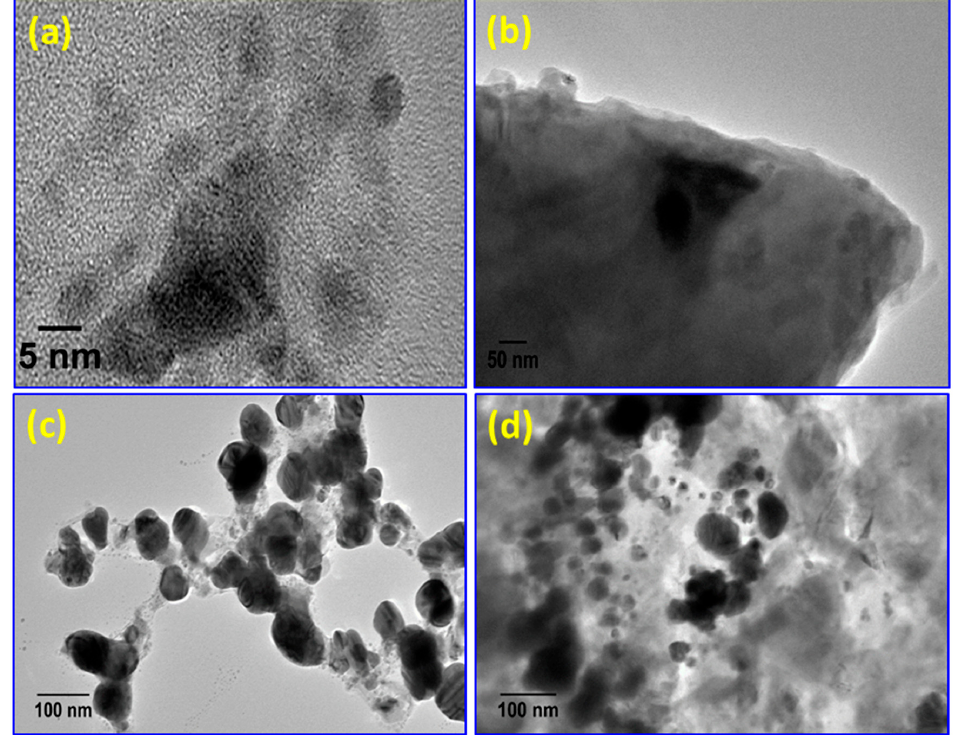
Figure 7. HRTEM micrographs of ( a ) AgNPs and ( b ) PS/AgNPs; ( c ) PMMA/AgNPs; and ( d ) PSMMA/AgNPs nanocomposites.